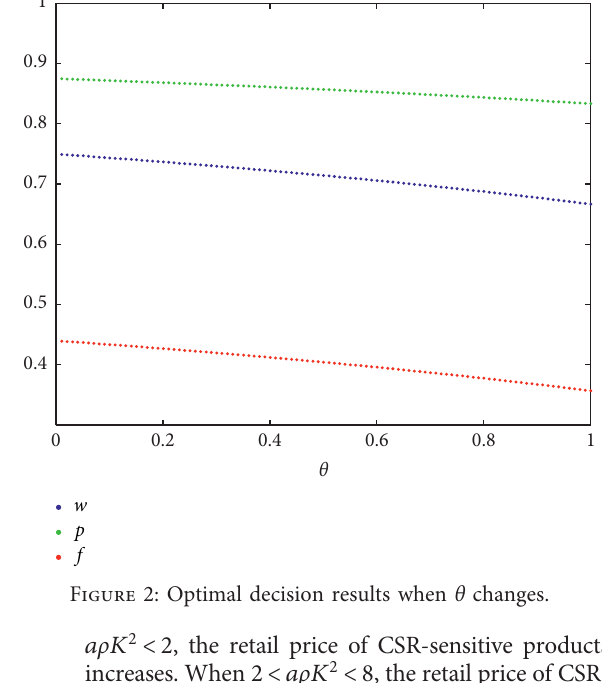
Figure 2: Optimal decision results when θ